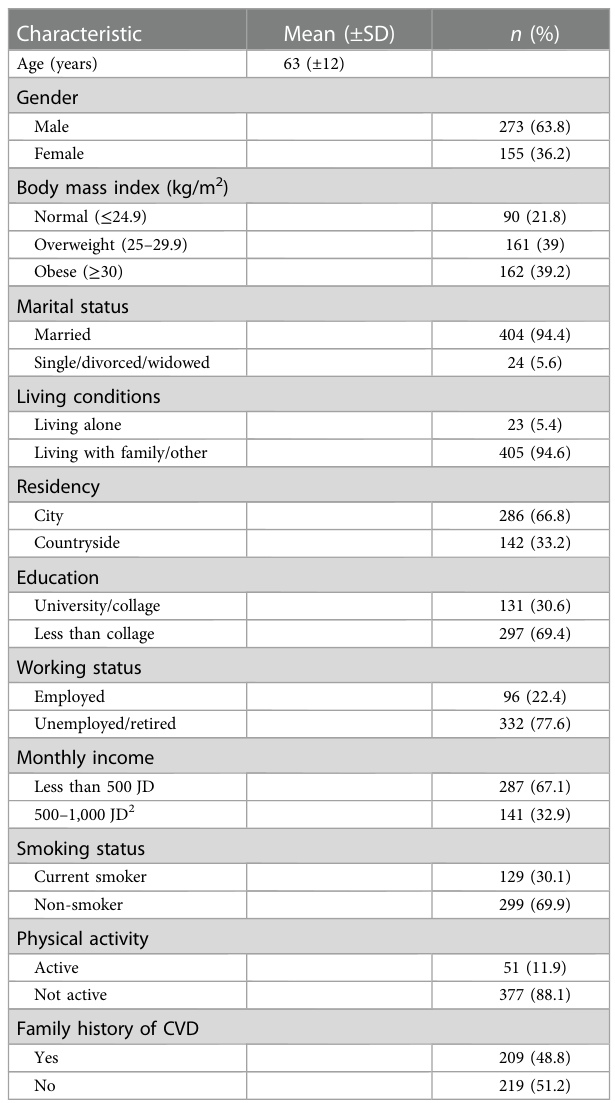
TABLE 1 Demographic characteristics of the study participants ( n